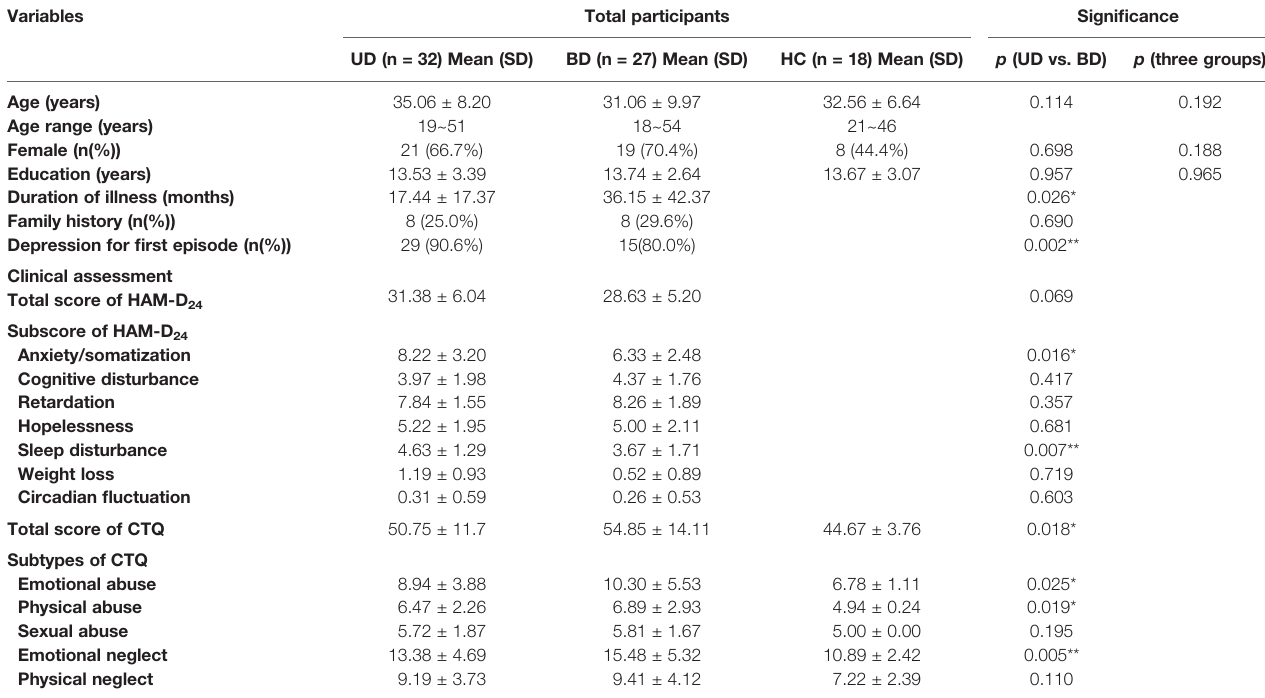
TABLE 1 | Demographic and clinical characteristics of unipolar depression, bipolar depression, and healthy controls.